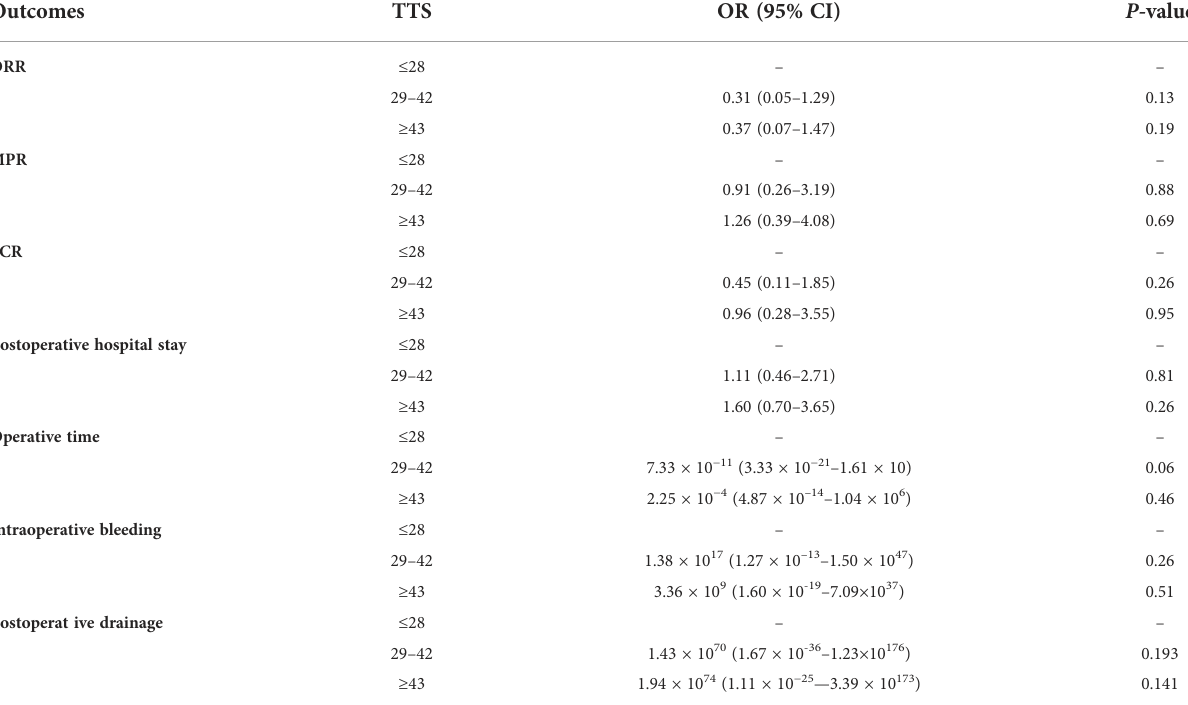
TABLE 3 Multivariable regression analysis was performed to adjust for confounders including tumor size and histology, and surgical procedures. Outcomes TTS OR (95%